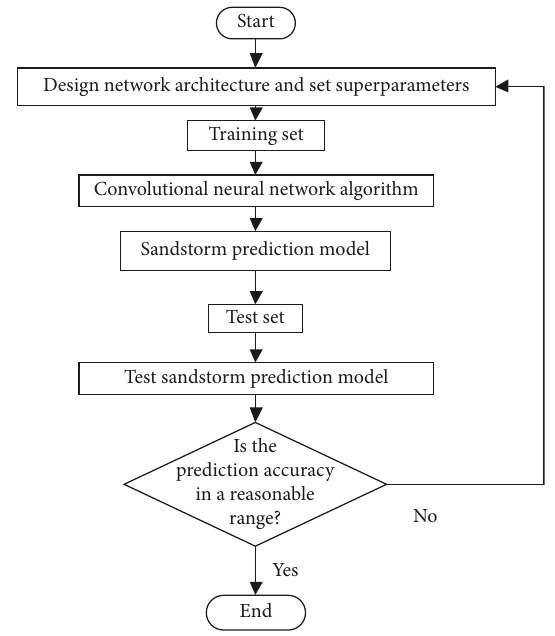
Figure 6: Training process of sandstorm prediction model based on convolutional neural network